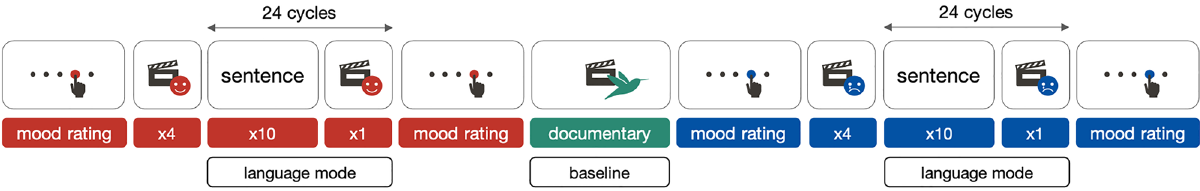
Figure 4. The experimental procedure following the assignment to the native (L1) or non-native (L2) language condition (“ × 4”, “ × 10”, and “ × 1” specify how many items were presented in a wicz University, Poznań. Participants were randomly assigned to one of the two language blocks: Polish (L1) or English (L2) (a counterbalanced order). They were seated in a dimly lit and quiet booth, 75 cm away from a LED monitor with a screen resolution of 1280 × 1024 pixels. The mood-inducing and linguistic stimuli were presented with E-Prime 3.0 (Psychology Software Tools Inc.). The positive and negative mood-inducing film clips were presented in separate mood blocks. Participants watched 28 mood-inducing films in each such block ( n Total = 56) and were instructed to put themselves in the targeted mood 74 by imagining themselves as one of the protagonists and sympathizing with them 75 . In between the mood blocks, participants watched a 10-min low-arousing non-narrative nature documentary, aiming at neutralizing the mood state induced by the first mood block and establishing the baseline for the physiological parameters 76 . To measure the effectiveness of the mood manipulation, participants were asked to rate their current affective state before and after each mood block on valence and arousal scales and to complete the Polish version of the PANAS 77 (as translated into Polish by Fajkowska & Marszał-Wiśniewska 78 ). In each mood block, participants first watched four film clips to induce the targeted mood state, and they were then alternately presented with another film clip to sustain the evoked state (i.e., continuous mood induction) and a set of 10 sentences in the language assigned to them (i.e., Polish or English). Participants were asked to perform a semantic decision task, wherein they decided if the presented sentences were meaningful or meaning-